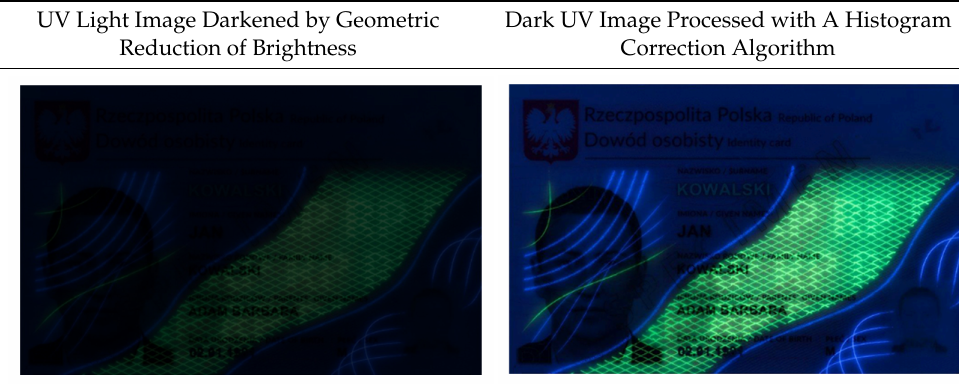
Table 3. Selected image processing results for 1/4, 1/16, and 1/64 of the initial UV light image brightness simulating differential images ( left ) and images with expanded histograms ( right